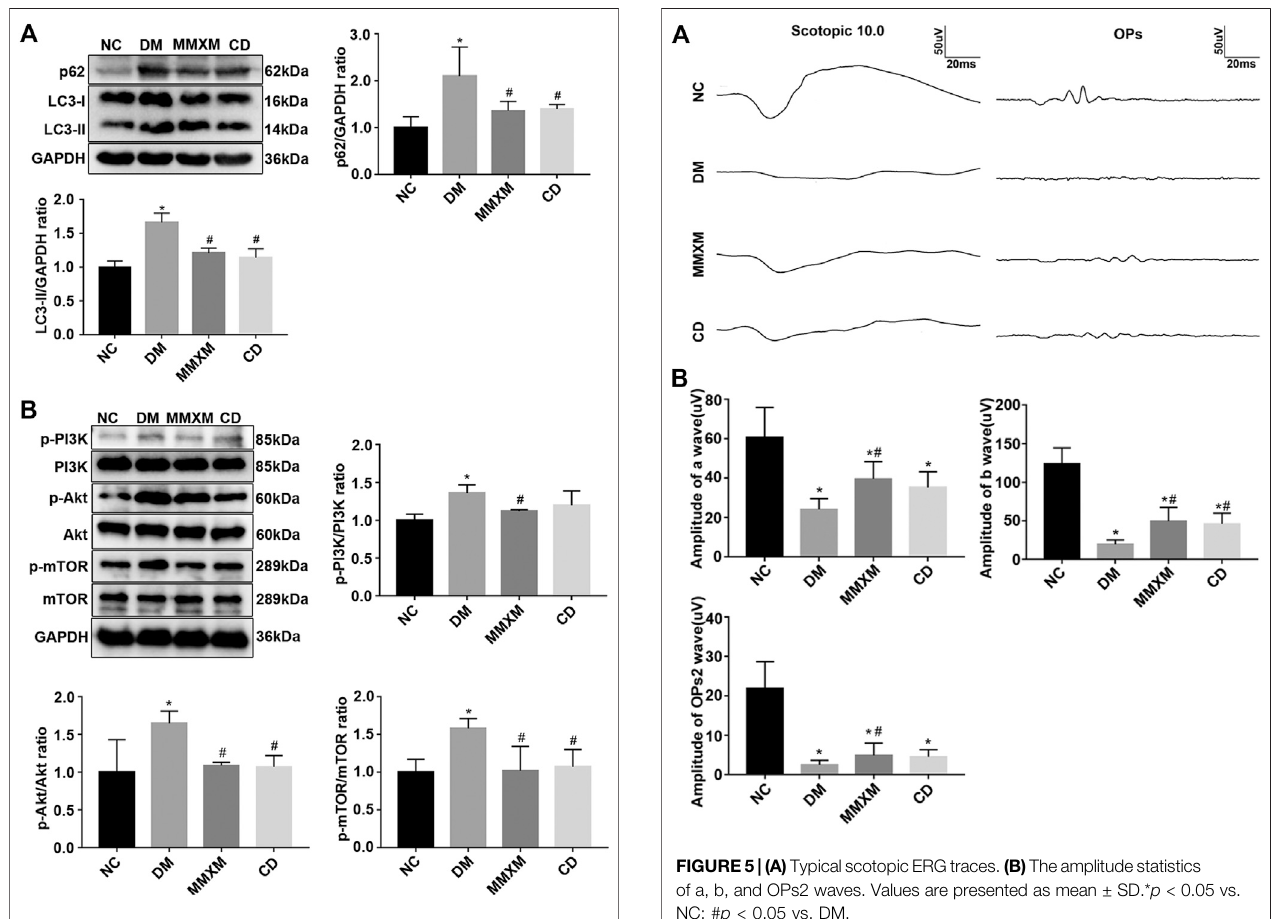
FIGURE 3 | (A) Relative expressions of p62 and LC3-II protein in retinal tissues. (B) Relative expression of p-PI3K/PI3K, p-Akt/Akt, p-mTOR/mTOR protein in retinal tissues. * p < 0.05 vs. NC; # p < 0.05 vs. DM.